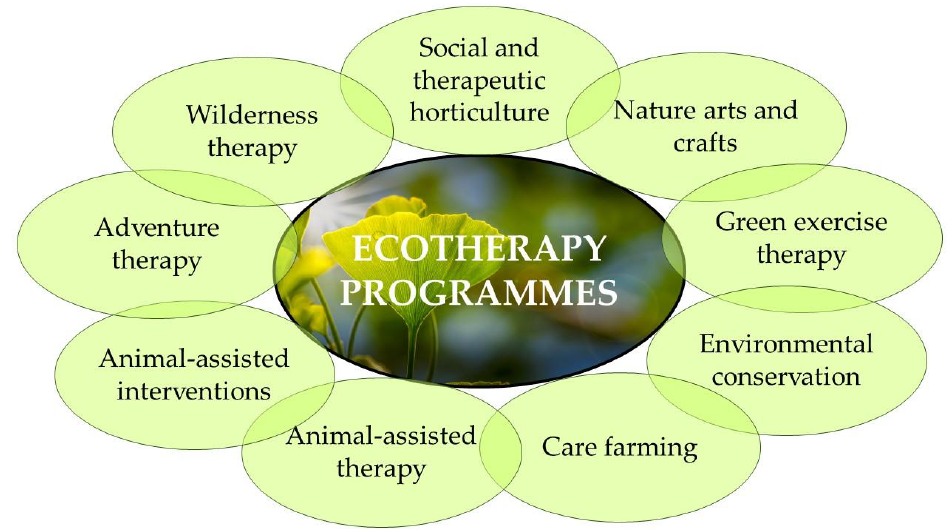
Figure 2. A variety of ecotherapy programmes, own elaboration based on a paper by MIND